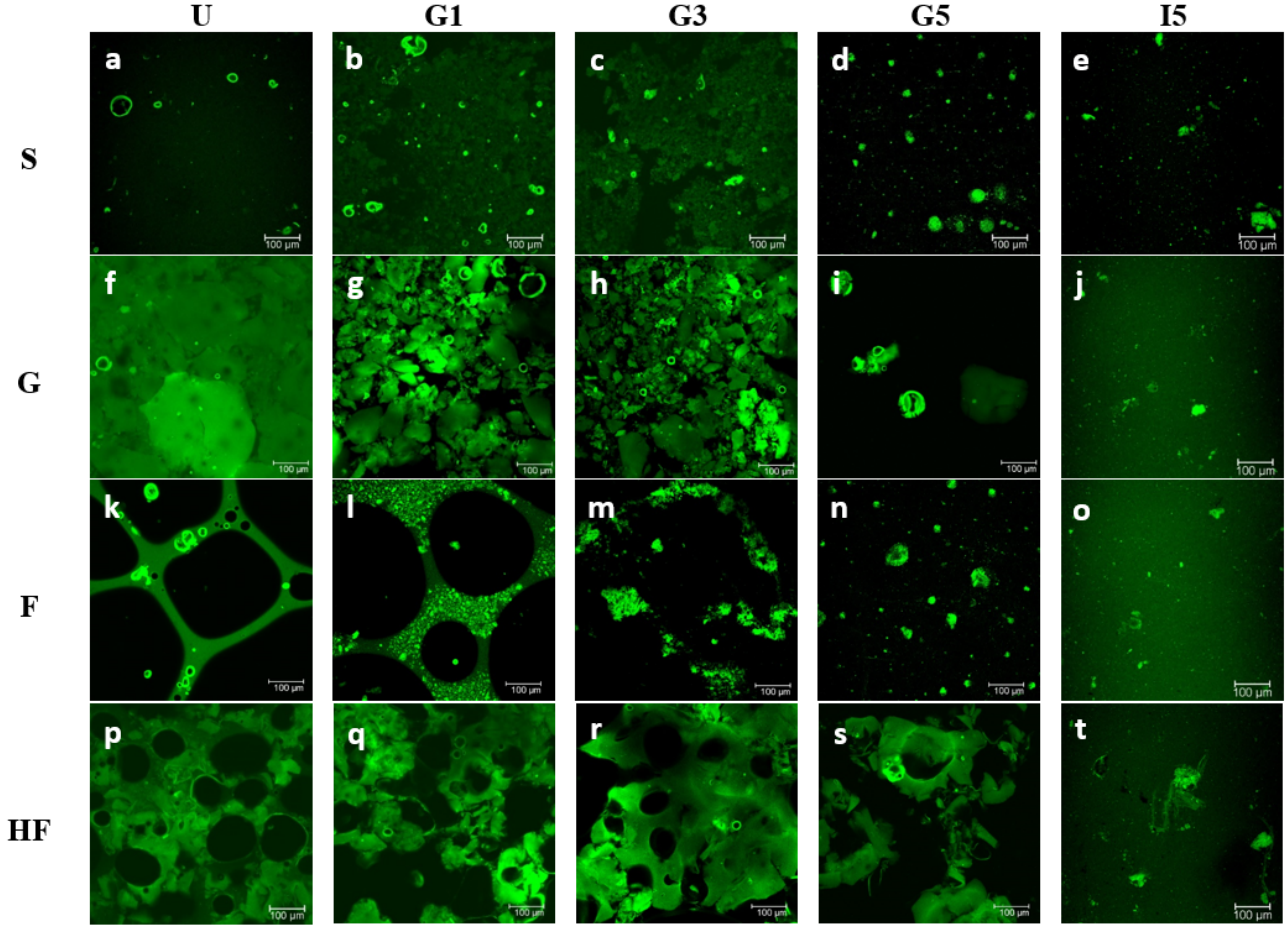
Figure 2. Representative confocal scanning laser microscopy (CSLM) images of four different potato protein isolate structures (4% protein, w / w ). Structures: Suspension (S) (figures a – e ), Gel (G) (figures f – j ), Foam (F) (figures k – o ), Heated Foam (HF) (figures p – t ). Different gastric endpoints shown: GE1 (8.26 min), GE3 (24.78 min), and GE5 (41.30 min). Scale bar: 100 μ m.